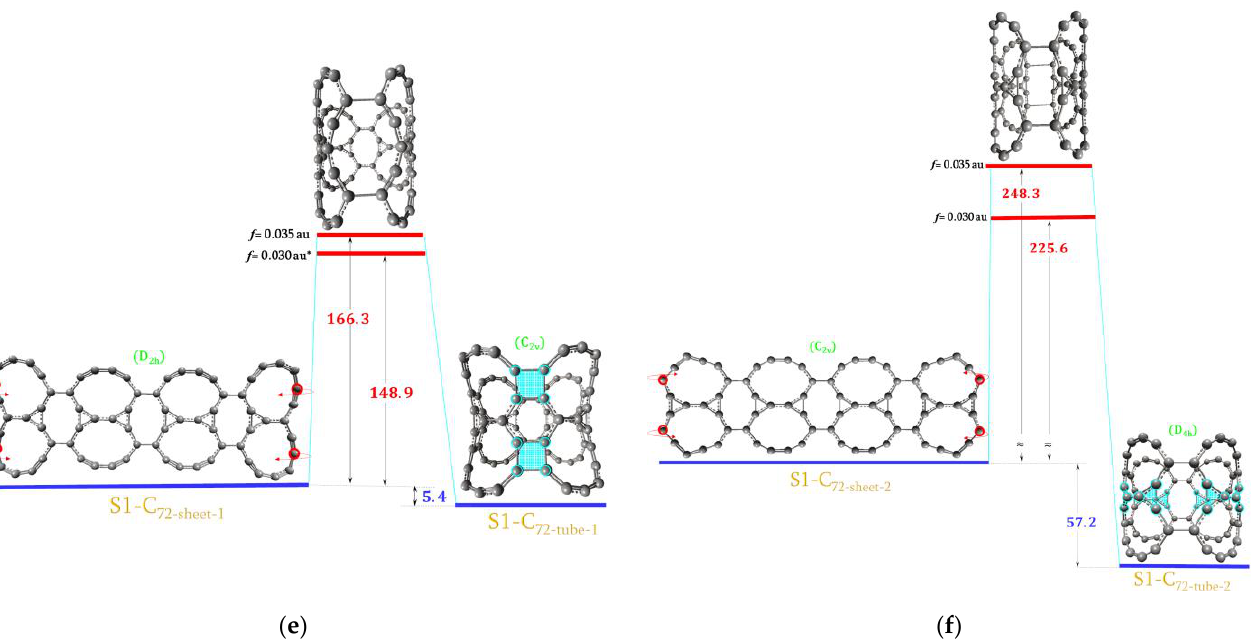
Figure 6. The energy diagram with the estimated upper limit of the energy demand for the formation of the ( a ) S1-C 36-ribbon molecule; ( b ) S1-C 36-sheet molecule; ( c ) S1-C 72-sheet-1 molecule; ( d ) S1-C 72-sheet-2 molecule; ( e ) S1-C 72-tube-1 molecule; ( f ) S1-C 72-tube-2 molecule. All values are in kcal/mol. * p <